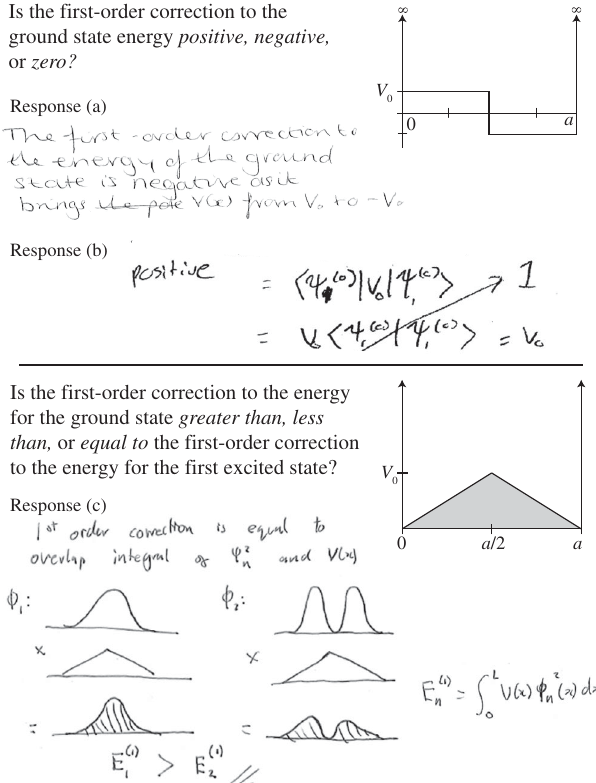
FIG. 5. Examples of student responses to one of the pretest questions (responses a and b to the top question) and one of the midtest questions (response c to the bottom question). These examples illustrate the representational competence level frame- work used to characterize students ’ reasoning. From top to bottom, the responses were coded as levels 1, 3, and 5,